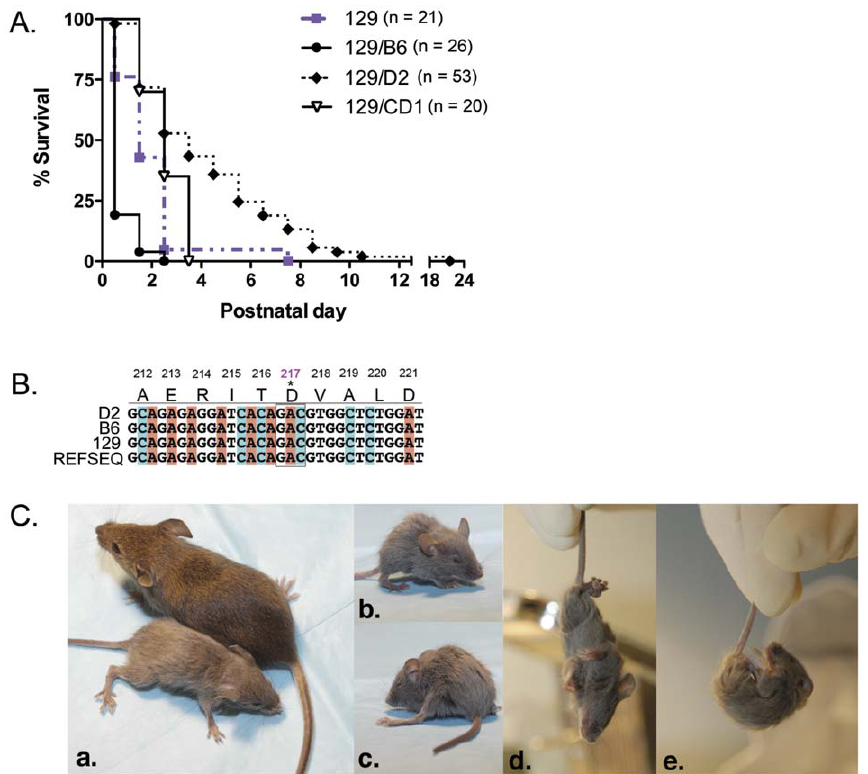
Figure 1. Mouse background modulates lifespan of Tor1a D E/ D E mice. A. Kaplan-Meier survival curves of Tor1a D E/ D E mice. D2, B6 and CD1-ICR genes modulate lifespan in Tor1a D E/ D E mice compared to original 129 background (Chi-square test used to generate p values: p , 0.0001 for 129 versus 129/D2, 129/C57; p , 0.05 for 129 versus 129/CD1). B. CLUSTALW2 multiple sequence alignment of genomic DNA from D2, B6, and 129 wildtype mice and Refseq demonstrates that all three strains have aspartic acid (D) at position 217 (*) of the mouse torsinA protein; figure depicts base pairs which correspond to the amino acid coding sequence 212–221 (AERITDVALD) C. Long-lived F2 129/D2 Tor1a D E/ D E mouse and Tor1a + / + littermate. 129/D2 Tor1a D E/ D E mouse is smaller than control at postnatal day 14 (a.), poorly groomed with partially closed eyes (b.), exhibits improper limb placement (c.), and demonstrates hindlimb clasping on tail suspension tests (d., e.).